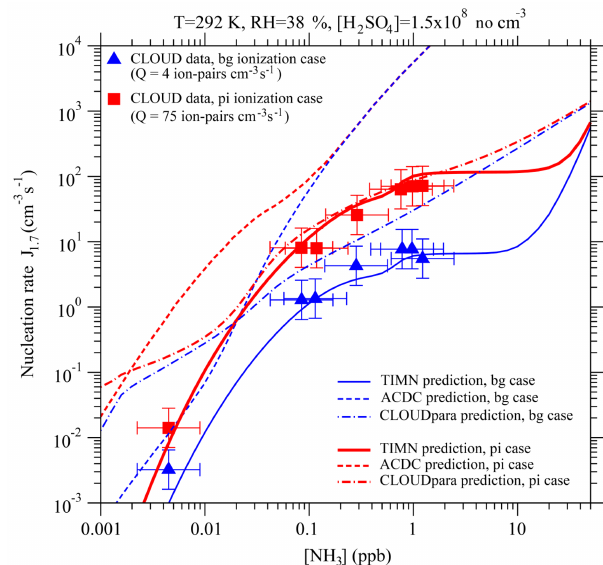
Figure 6. Effect of ammonia concentrations ([NH 3 ]) on effective nucleation rates calculated at a cluster mobility diameter of 1.7nm ( J 1 . 7 , lines) under the stated conditions with two ionization rates ( Q ) – background ionization, bg (blue), and ionization enhanced by a pion beam, pi (red). Also shown are predictions from the TIMN model, the Atmospheric Cluster Dynamics Code (ACDC) with ther- mochemistry obtained using the RI-CC2//B3LYP method (McGrath et al., 2012; Kürten et al., 2016), and an empirical parameteriza- tion of CLOUD measurements (CLOUDpara) (Dunne et al., 2016) indicated by solid, dashed, and dot-dashed lines, respectively. The symbols refer to CLOUD experimental data (Kirkby et al., 2011; Dunne et al., 2016), with the uncertainties in measured [NH 3 ] and J 1 . 7 shown by horizontal and vertical bars, respectively. To be com- parable, the CLOUD data points given in Dunne et al. (2016) under the conditions of T = 292K and RH = 38% with [H 2 SO 4 ] close to 1.5 × 10 8 cm − 3 have been interpolated to the same [H 2 SO 4 ] value ( = 1.5 × 10 8 cm − 3